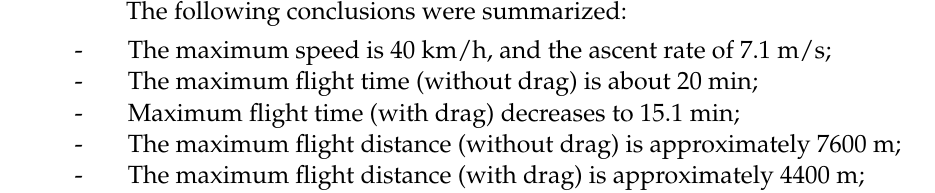
Figure 17. Online tests. ( a ) Range estimator; ( b ) Motor characteristics at full throttle.